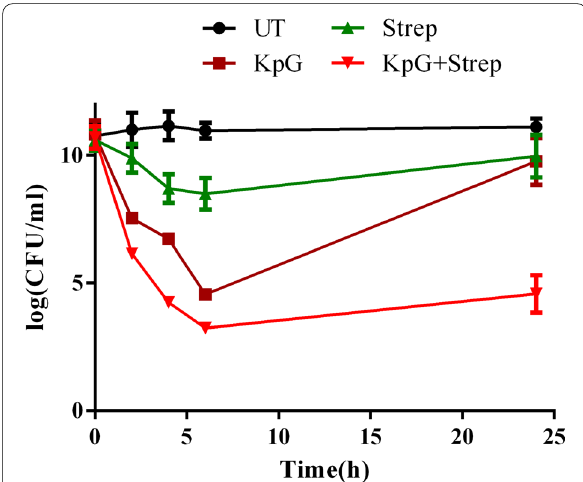
Fig. 4 KpG phages in combination with Streptomycin caused discernible reduction in colony counts in a time kill assay. 10 6 CFU/ ml of K. pneumoniae was inoculated along with 10 8 PFU/ml of KpG phages and Streptomycin (individually and in combination). Samples were withdrawn at 0, 2, 4, 6 and 24 h serially diluted and plated on to LA plates to determine colony counts. Experiments were performed in triplicates and error bar represent standard error of the